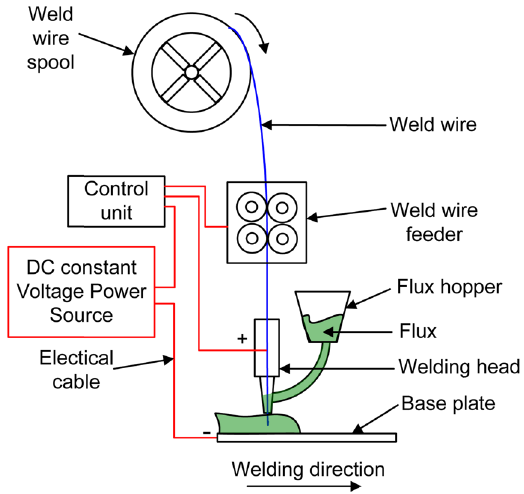
Figure 2: SAW equipment sketch ( status: power switched o ff ) .